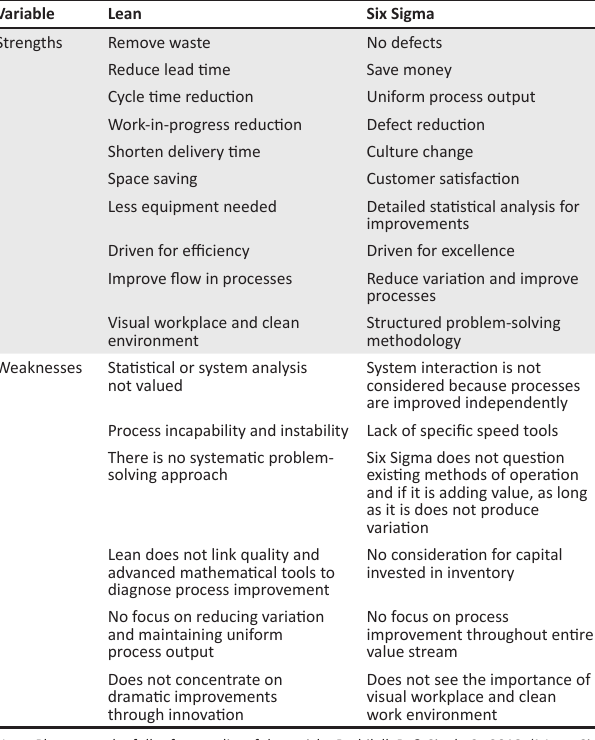
TABLE 1: Lean and Six Sigma strengths and weaknesses. Variable Lean Six